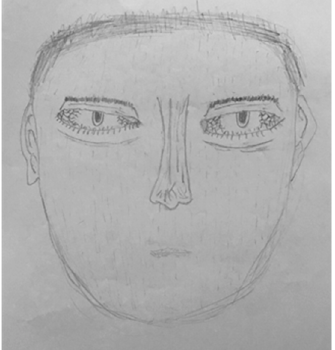
Figure 4. The drawing of a 16-year-old male participant who reported experiencing CPA. The significant drawing indicators included the emphasized or hair standing up, the emphasized or double ears, and the emphasized or double face line.